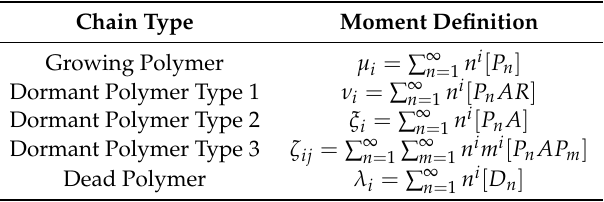
Table 1. Polymer moment